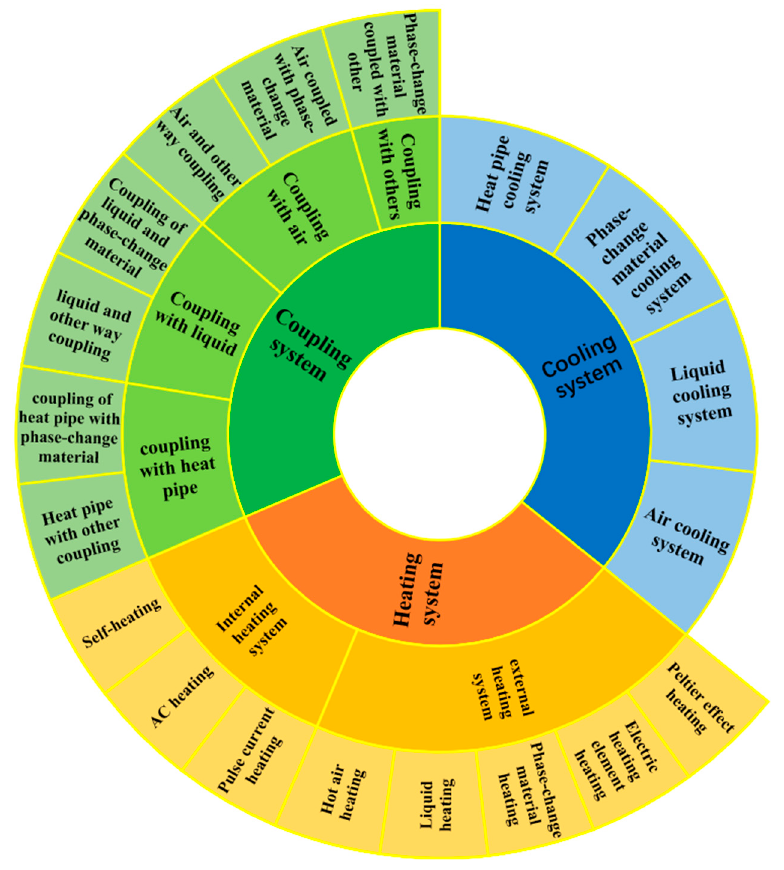
Figure 1. Classification of power battery thermal management systems.